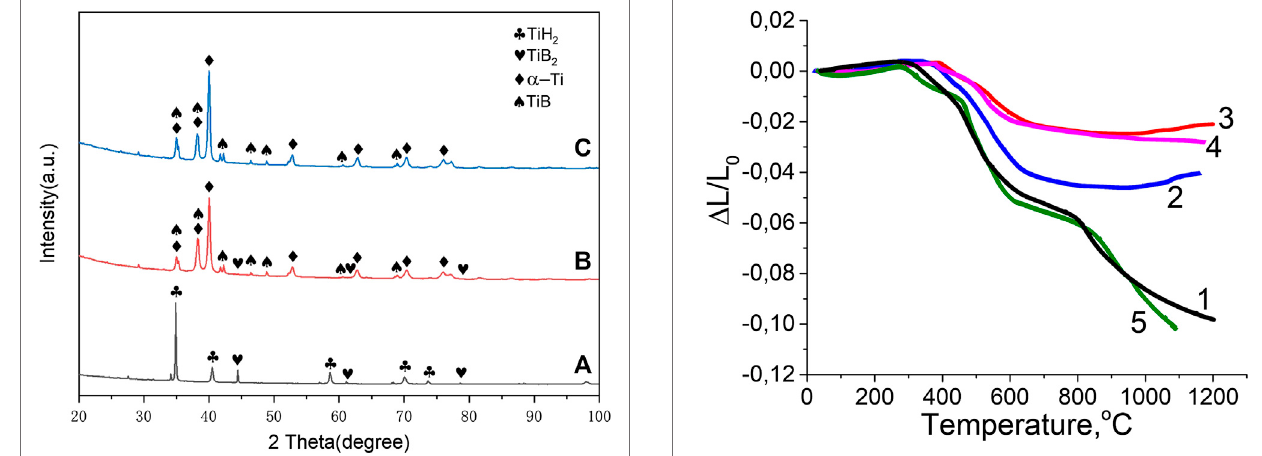
FIGURE 3 | X-ray diffraction patterns of initial TiH 2 + 10% TiB 2 powder blends (A) ,materialafter fi rstsintering (B) andaftersecondhydrogenationand sintering stage (C) .